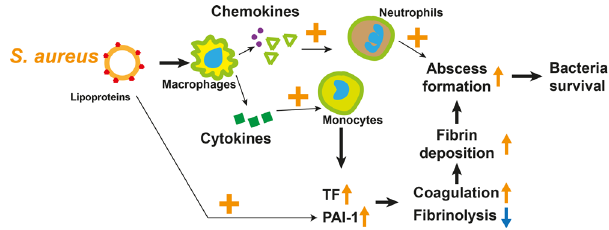
Fig. 8 Schematic diagram of proposed new function of S.